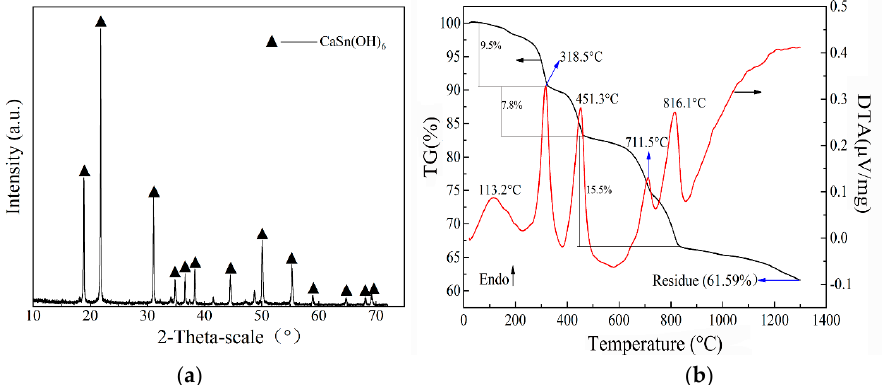
Figure 8. XRD pattern ( a ) and thermo-gravimetric and differential thermal analysis (TG–DTA) curves ( b ) of the precursor (CaSnO 3 ·3H 2 O).